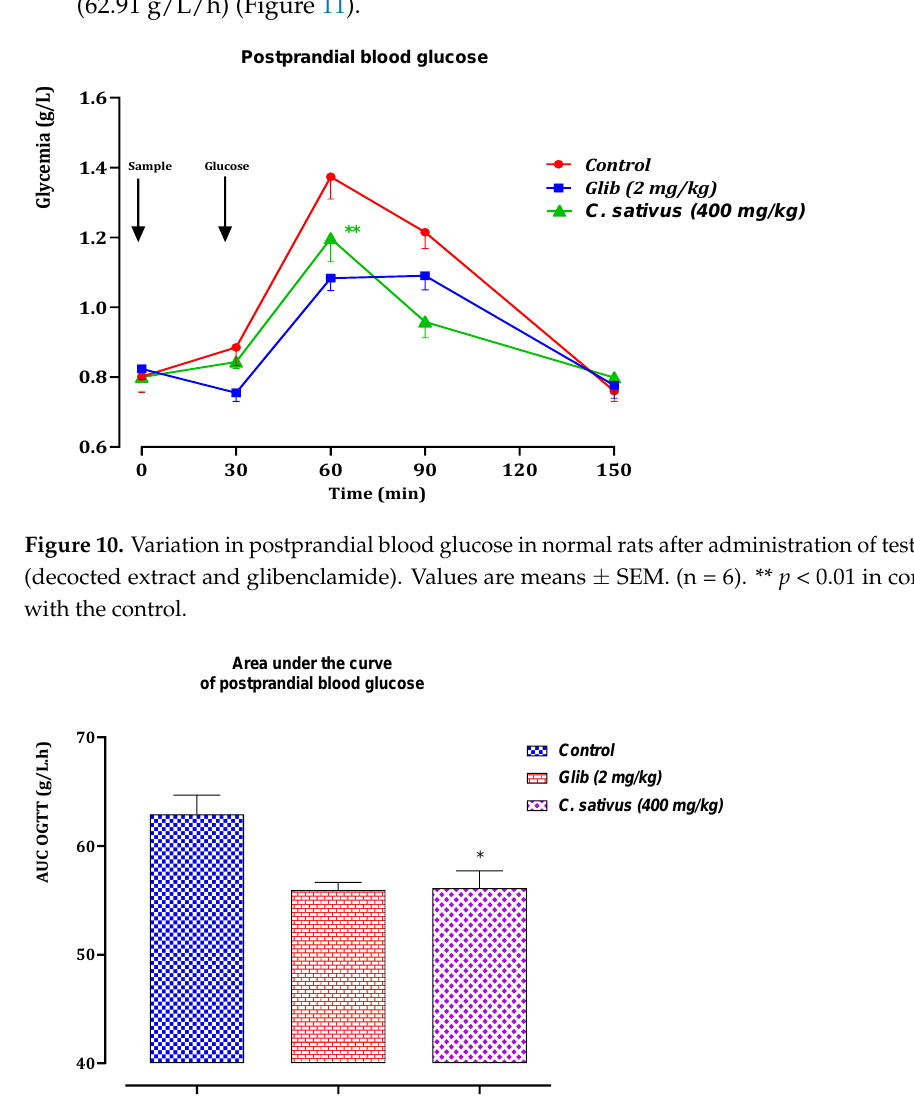
Figure 11. Variation in the area under the curve of postprandial blood glucose in normal rats after